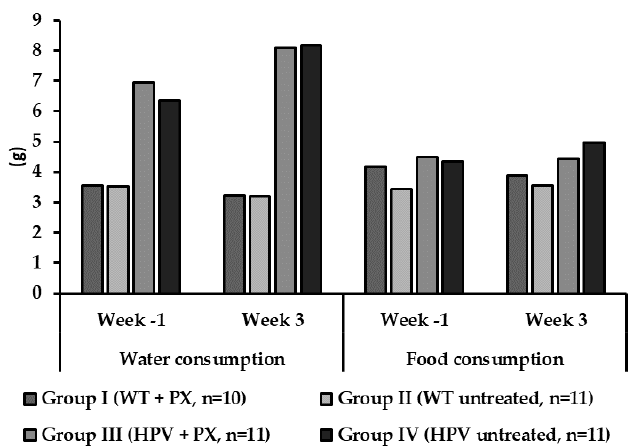
Int. J. Mol. Sci. 2019 , 20 , x FOR PEER REVIEW Figure 1. Mean values of food and water consumption per animal per day in the first and last experimental week for each experimental group. HPV—human papillomavirus; PX—parecoxib; Figure1. Meanvaluesoffoodandwaterconsumptionperanimalperdayinthefirstandlastexperimental WT—wild ‐ type. week for each experimental group. HPV—human papillomavirus; PX—parecoxib; WT—wild-type.